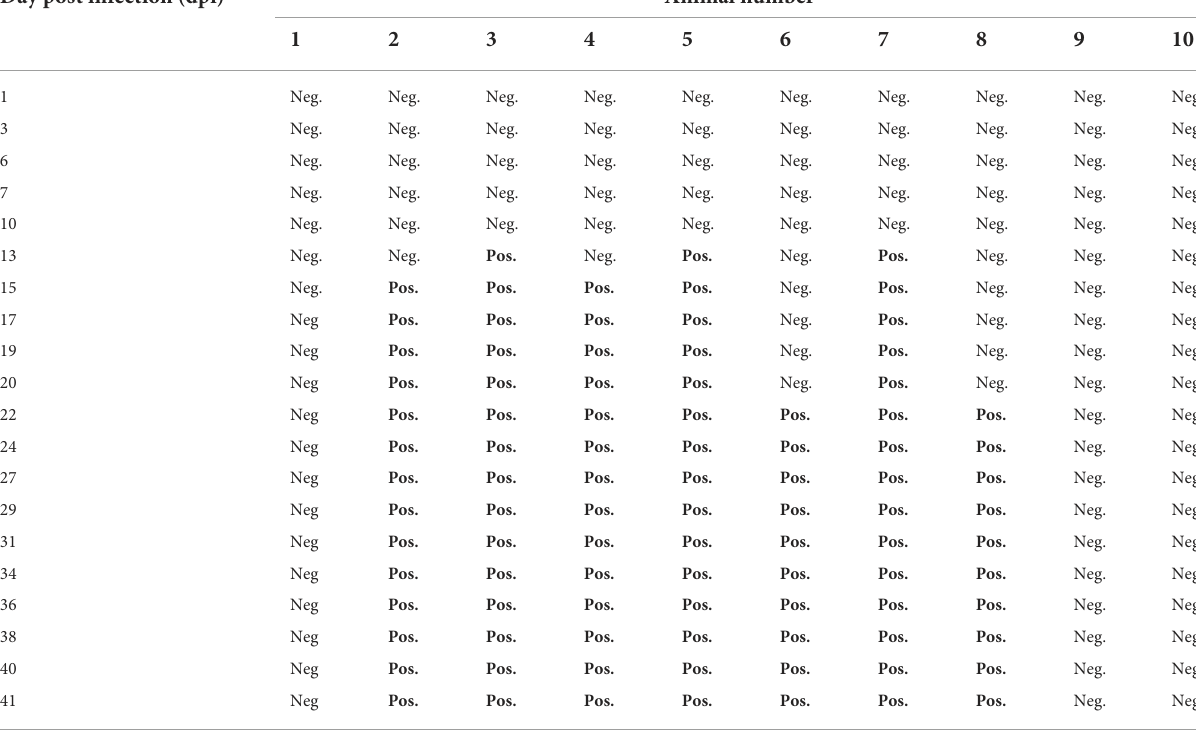
TABLE 4 Neutralization test results of sera from the experimental animals. No. bull Boldmeanspositive.